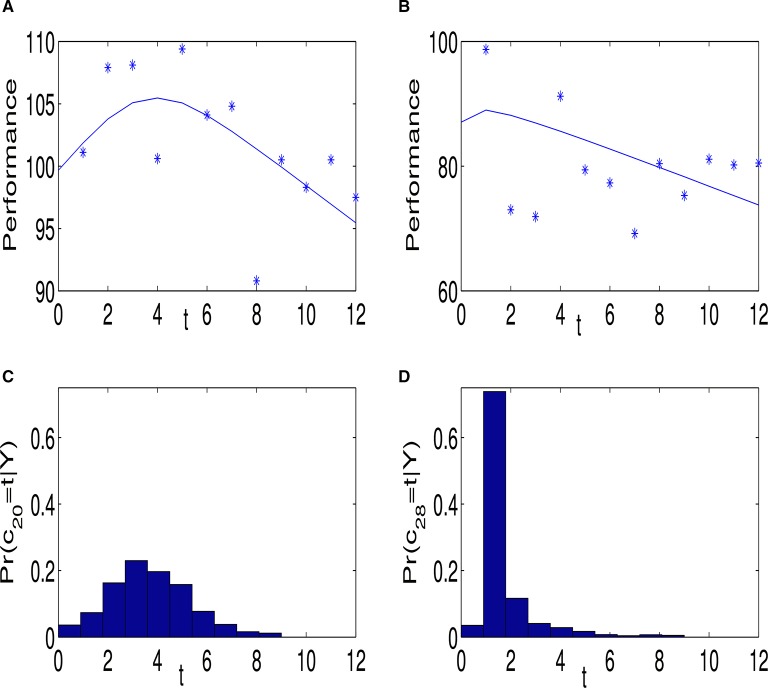
(A) Shows the data and fitted line for individual 20, who was classified as an entity theorist. The observed data are indicated by “*” and the posterior mean of the regression line is given by the blue line. (C) shows the posterior probability of the commencement of the spiral cj. (B,D) are corresponding plots for individual 28, who was also classified as an entity theorist.